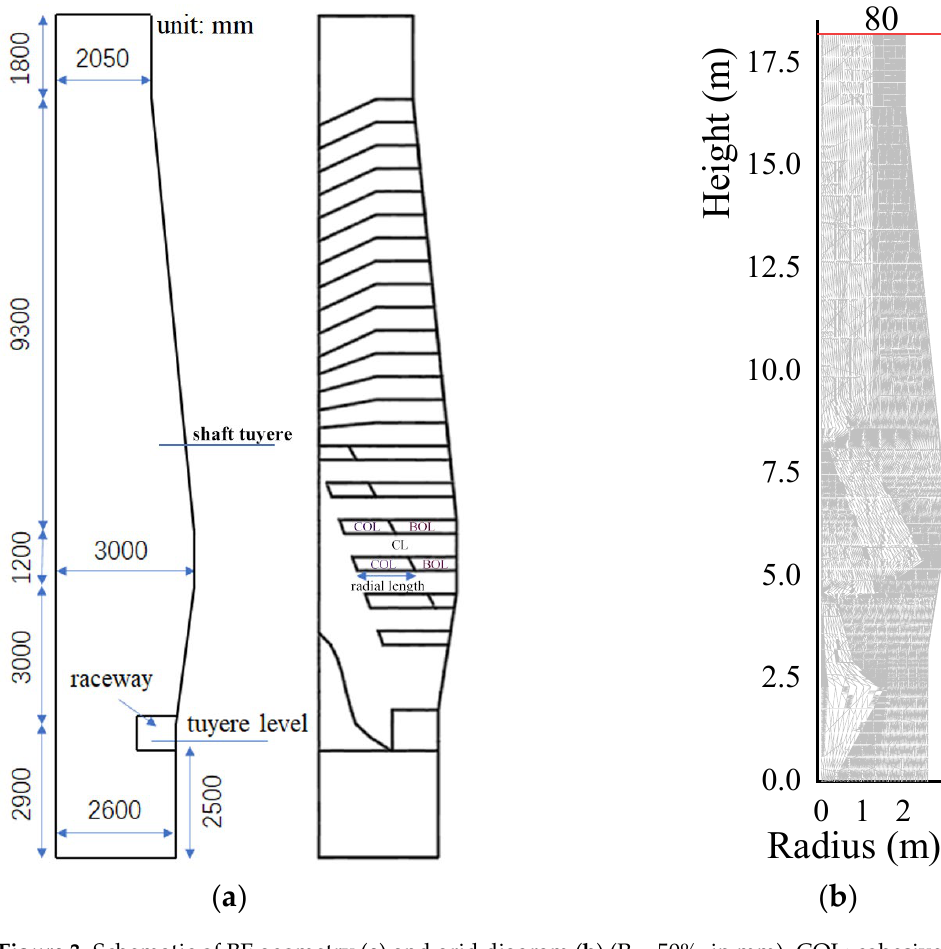
Figure 3. Schematic of BF geometry ( a ) and grid diagram ( b ) (R = 50%, in mm). COL: cohesive ore layer, BOL: bulk ore layer, CL: coke layer. A validated 2D steady-state porous model is used in this work. Velocity-inlet is used for both hearth and shaft tuyeres. Operating pressure is set zero kPa. Gravitational acceleration is − 9.8 m/s 2 in the Y direction. Boundary conditions are shown in Table